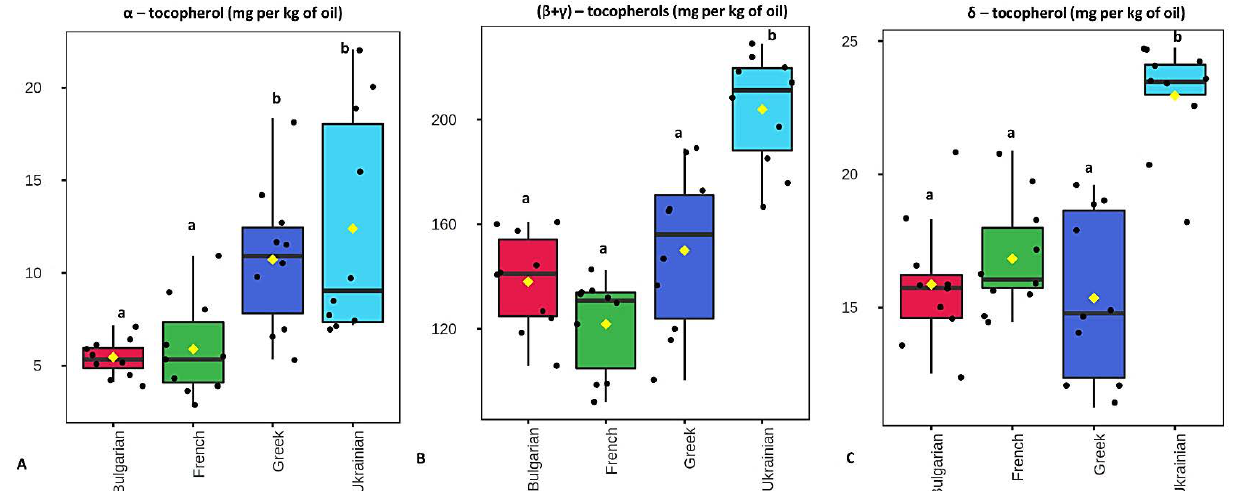
Figure 2. Box plot of α -tocopherol ( A ) and the sum of β - and γ -tocopherols ( B ) and δ -tocopherol in oils ( C ) from Bulgarian, French, Greek, and Ukrainian walnuts. Box plot values highlighted with different Latin letters differ significantly at α = 0.001.